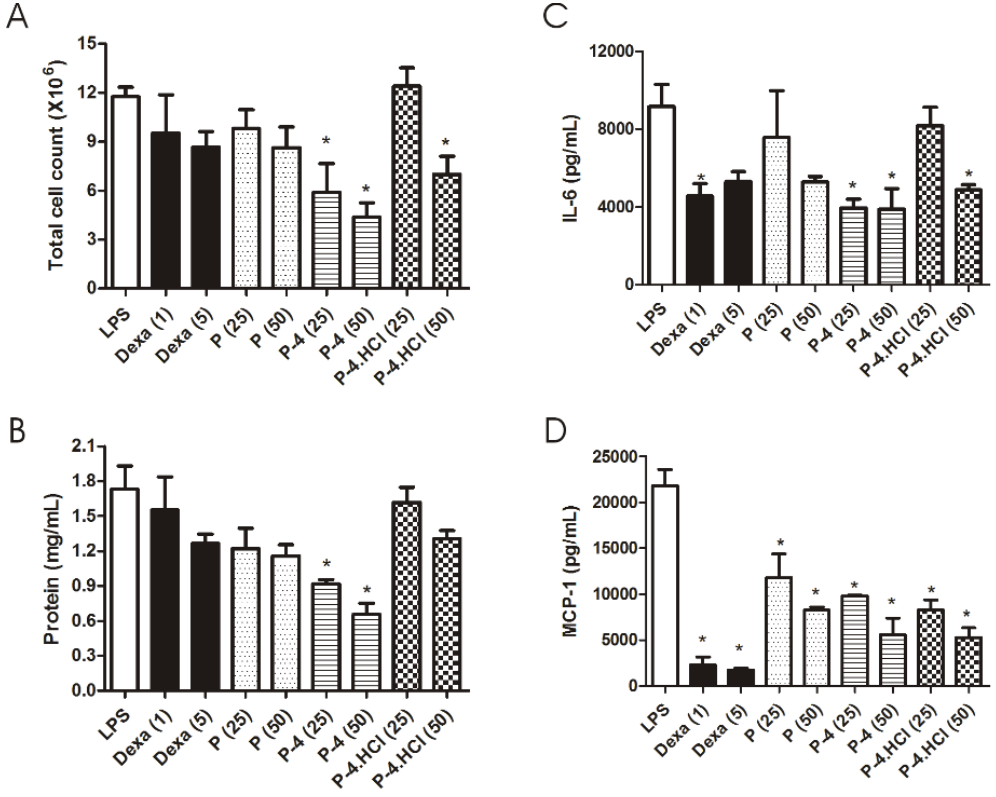
Figure 5. Biological responses of ALI-bearing rats treated with Dexa, paeonol and selected APDs on ( A ) total cell counts, ( B ) total protein concentrations, ( C ) IL-6 and ( D ) MCP-1 in bronchoalveolar lavage fluid (BALF). Significant differences between each treatment group and LPS-treated (positive control) group at p values less than 0.05 were annotated with *.